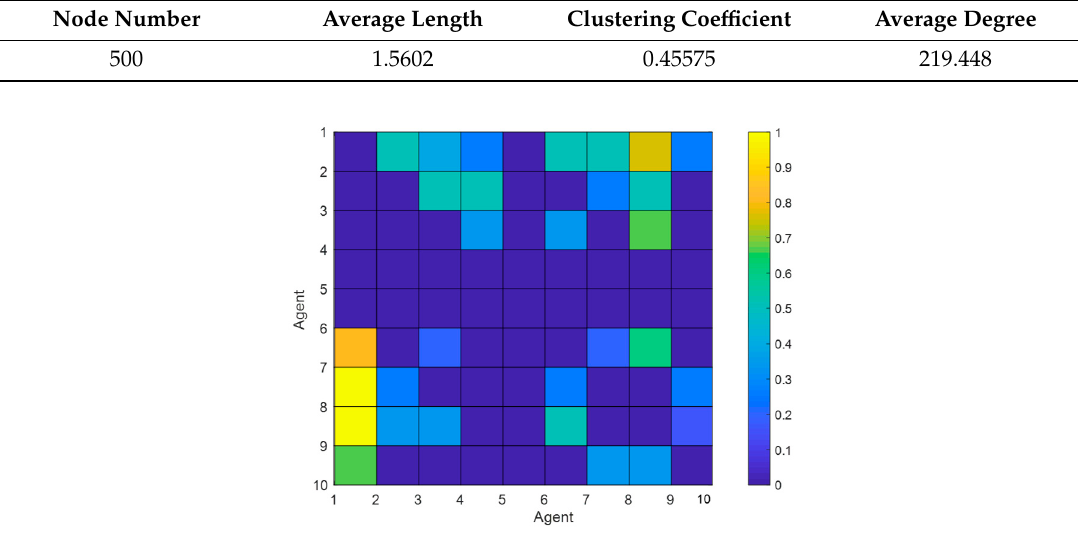
Table 1. Network parameters.